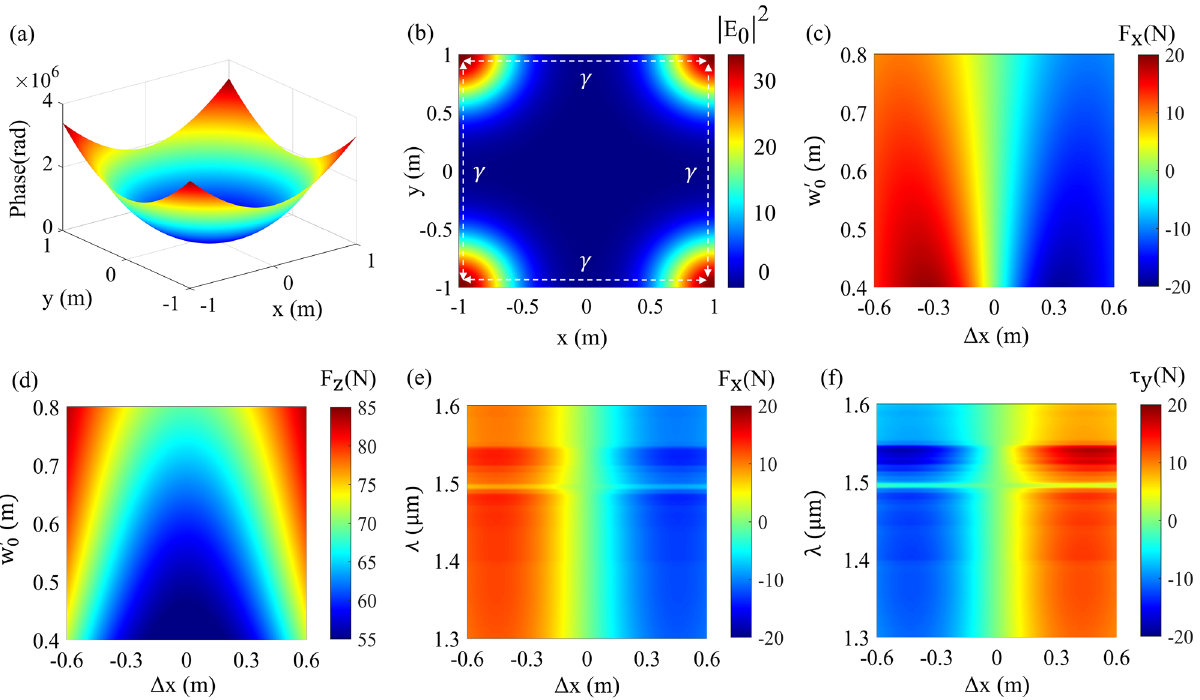
Figure 6. ( a ) The imprinted phase gradient on the metasail elements, where the inner side (reflective) and outer (transmissive) are diffractive spherical and parabolic respectively. ( b ) The intensity profile of the incident laser beam consisting of four Gaussian beams at the corners of the sail. ( c , d ) The imparted thrust and F x component of induced force as a function of beam spot size and the displacement. ( e , f ) Illustrate the F x and τ y component of the induced optical force and torque as a function of the wavelength and the displacement, respectively. Generated by